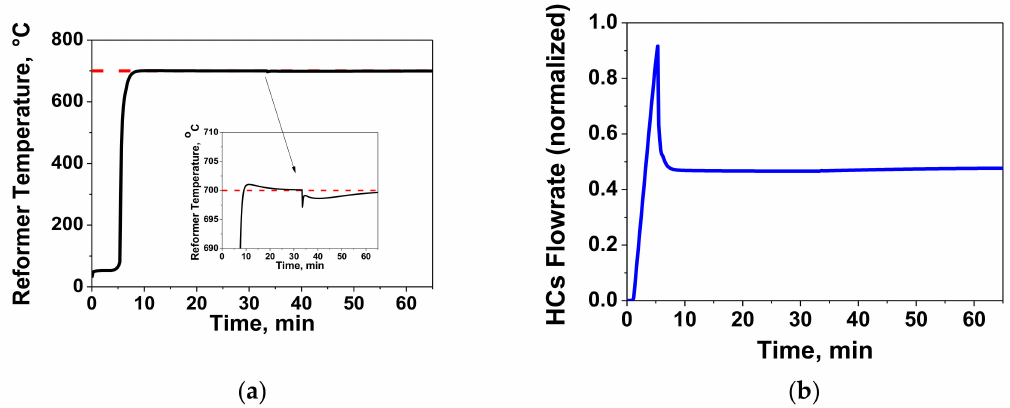
Figure 4. ( a ) Temperature profile of the reformer (TC1 controller) and ( b ) HCs flowrate manipulation at the